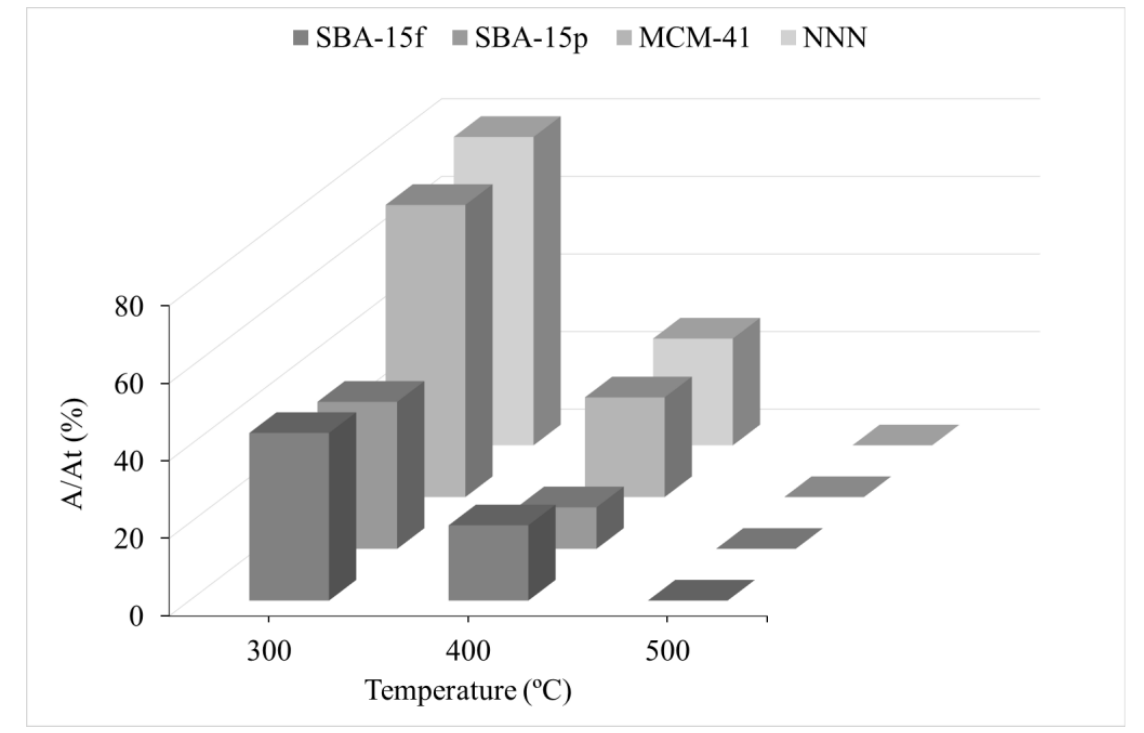
Figure 12. Evolution of NNN for sole NNN and NNN with three catalysts under the inert atmos- phere.